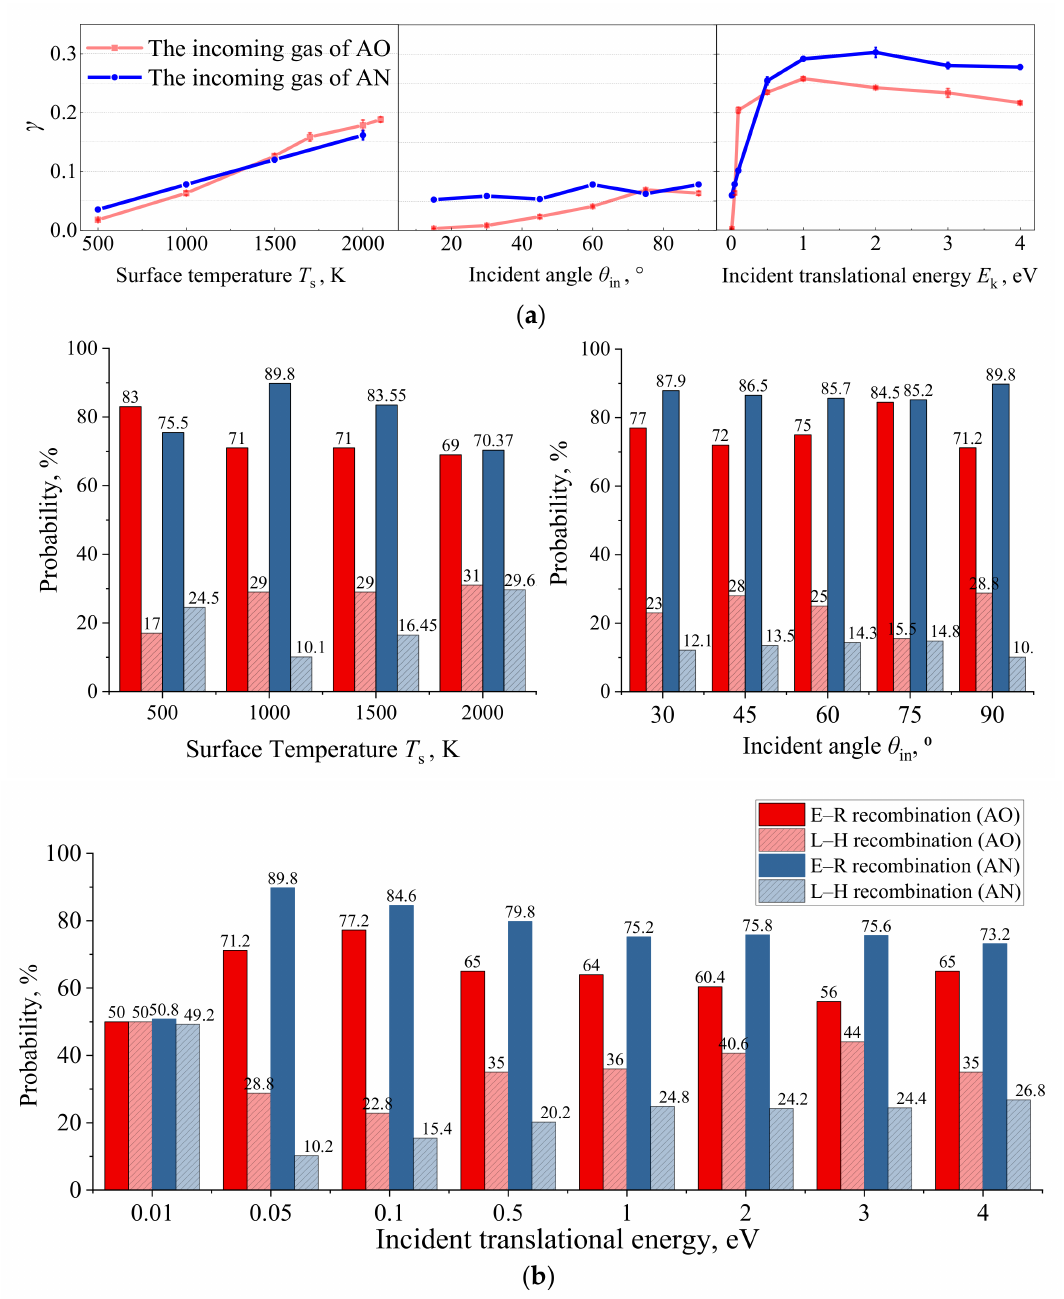
Figure 13. Silicon dioxide surface catalytic recombination coefficient and reaction mechanism analysis for the case with the incoming gas containing full AN (Models IV-17–34). ( a ) Surface catalysis recombination coefficient calculations. ( b ) Recombination mechanism